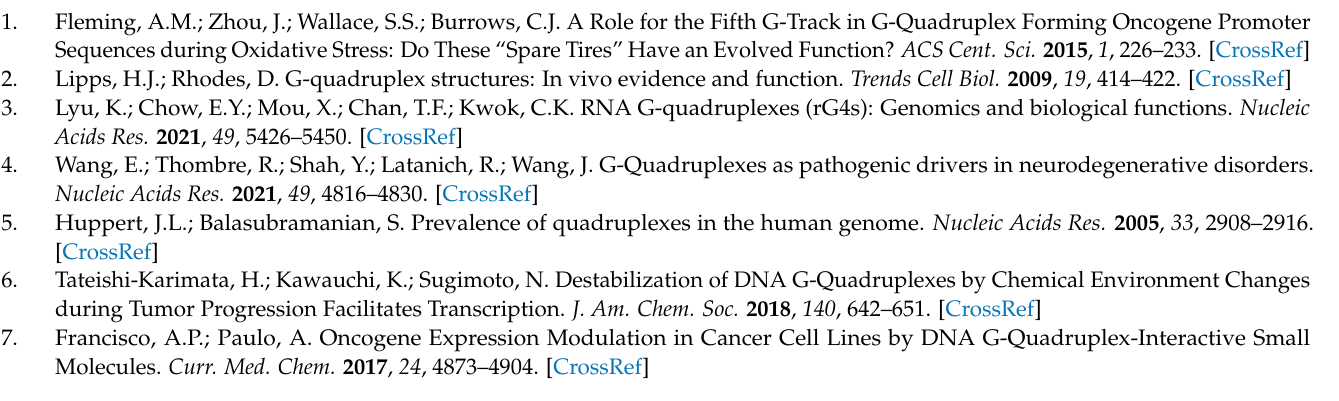
Table S2: The primer